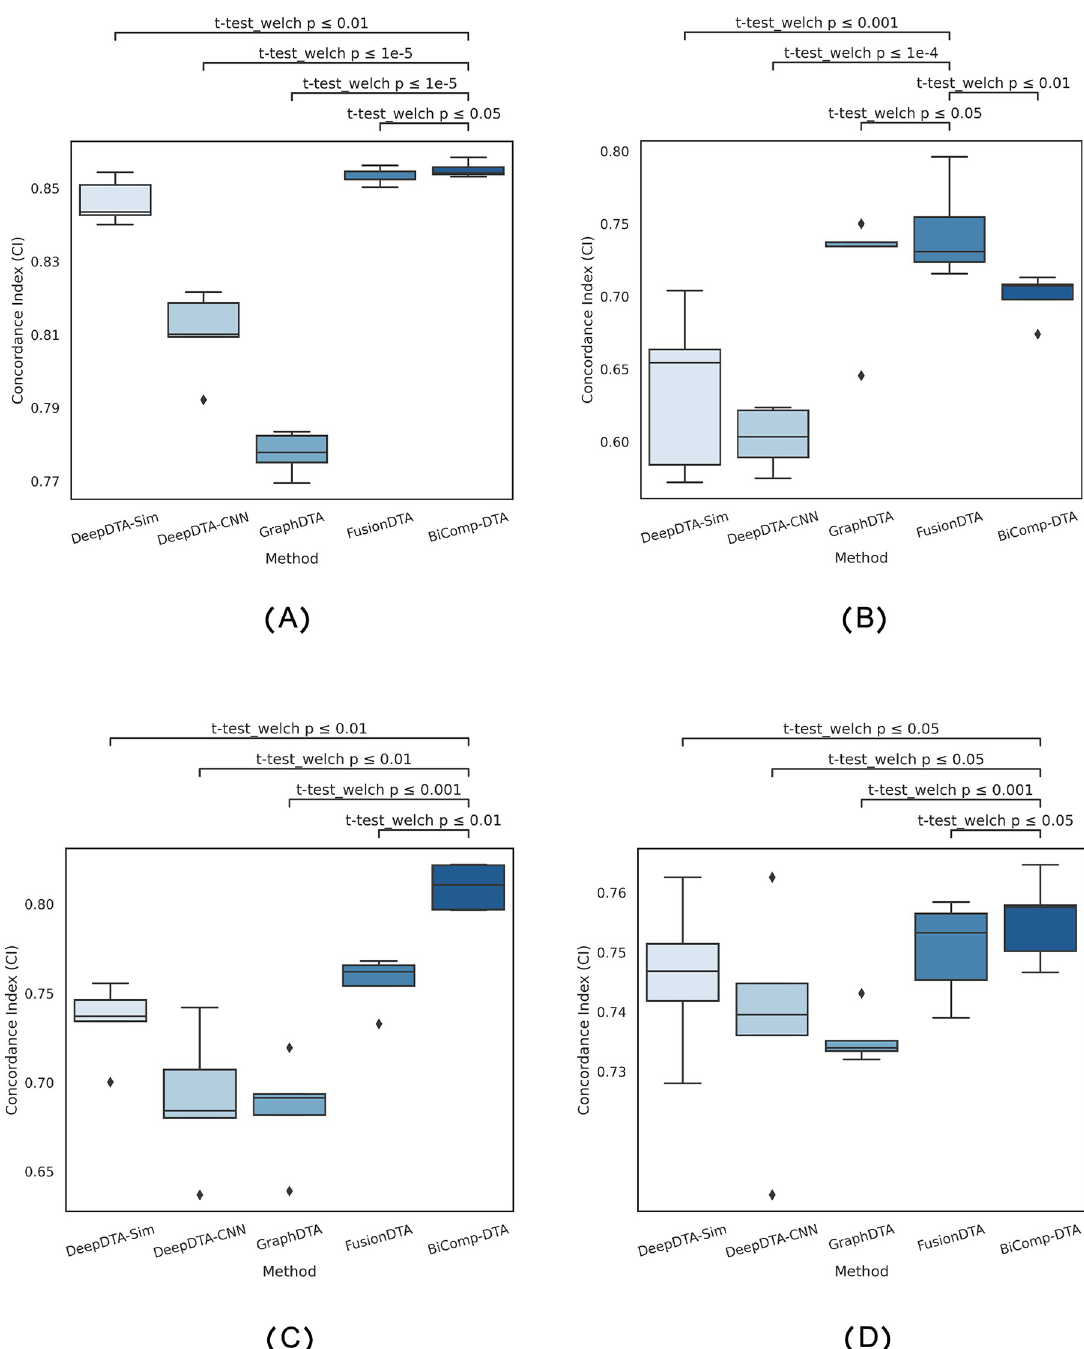
Fig 4. Full distributions of CI values and statistical tests for the BiComp-DTA, compared to the alternative methods, considering alternative splitting settings, (A) cold-protein, (B) cold-drug, and (C) cold-protein-drug settings—Davis dataset, (D) HIV1 protease splitting setting- PDBbind